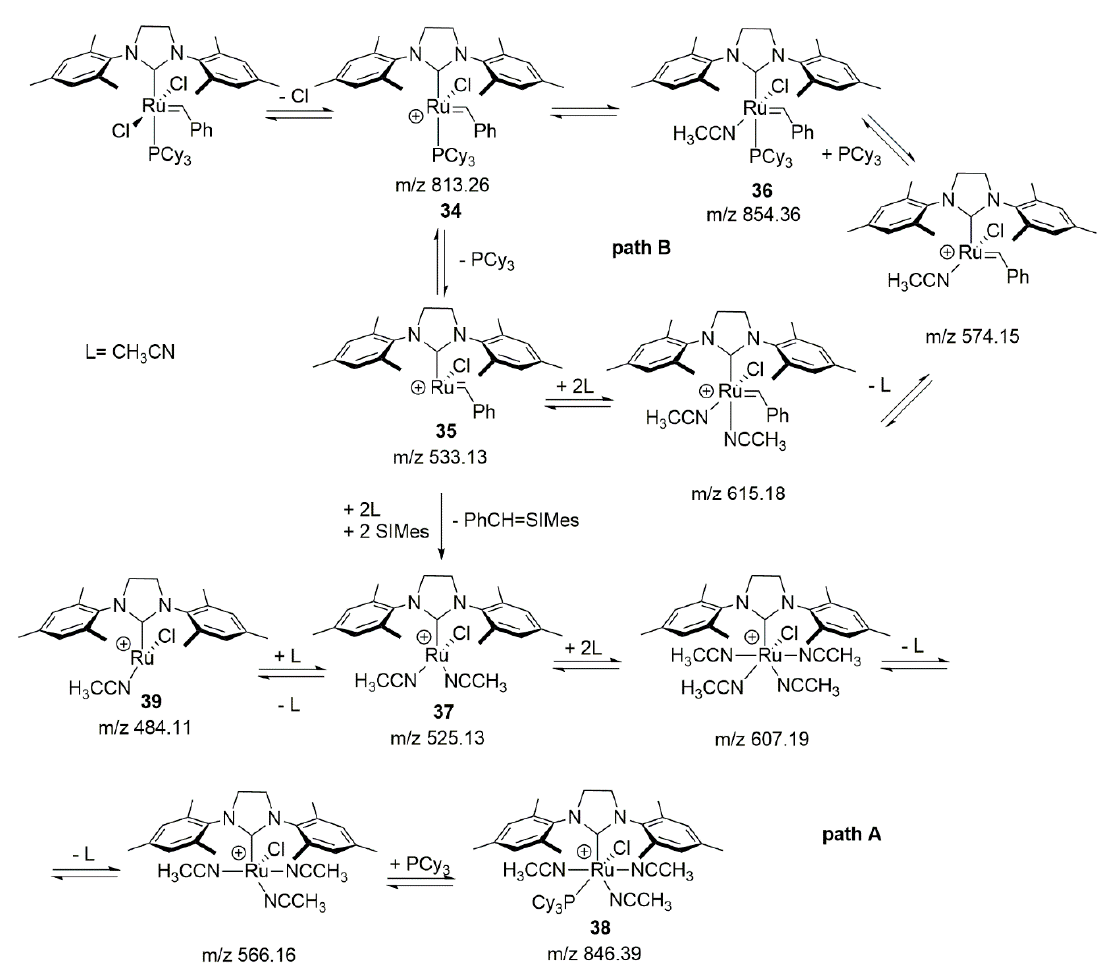
Scheme 36. The mechanism of decomposition of GII by CH 3 CN based on mass spectrometry